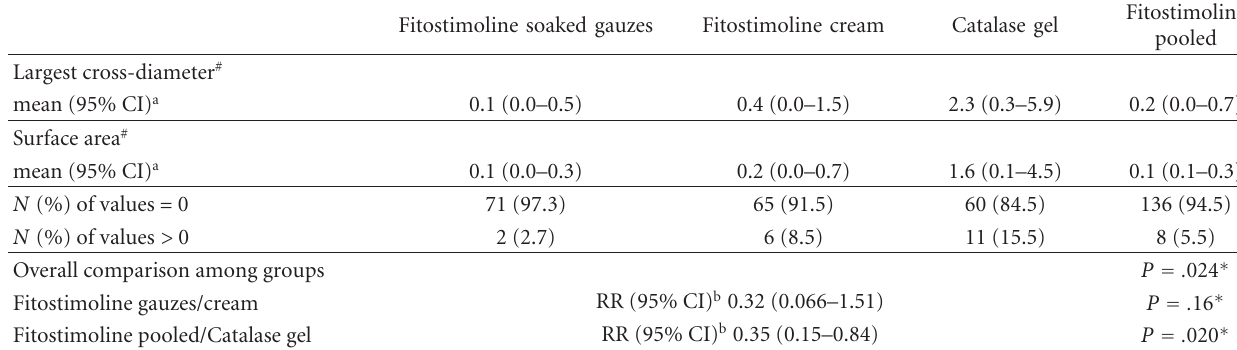
Table 2: Lesion size and lesion disappearance (healing) at end of study in the e ffi cacy